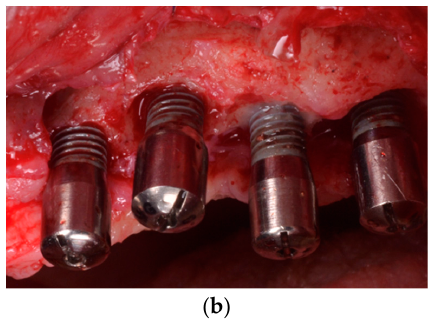
Figure 2. ( a ) Clinical appearance of implants placed in bone augmented with anorganic bovine bone and autogenous bone